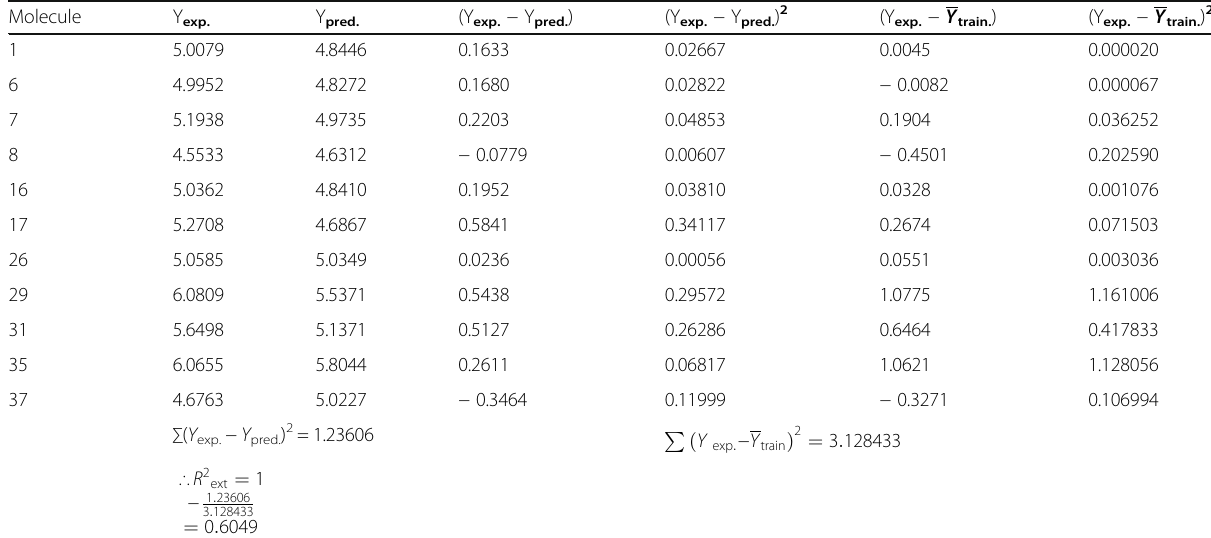
Table 4 External validation of the built model